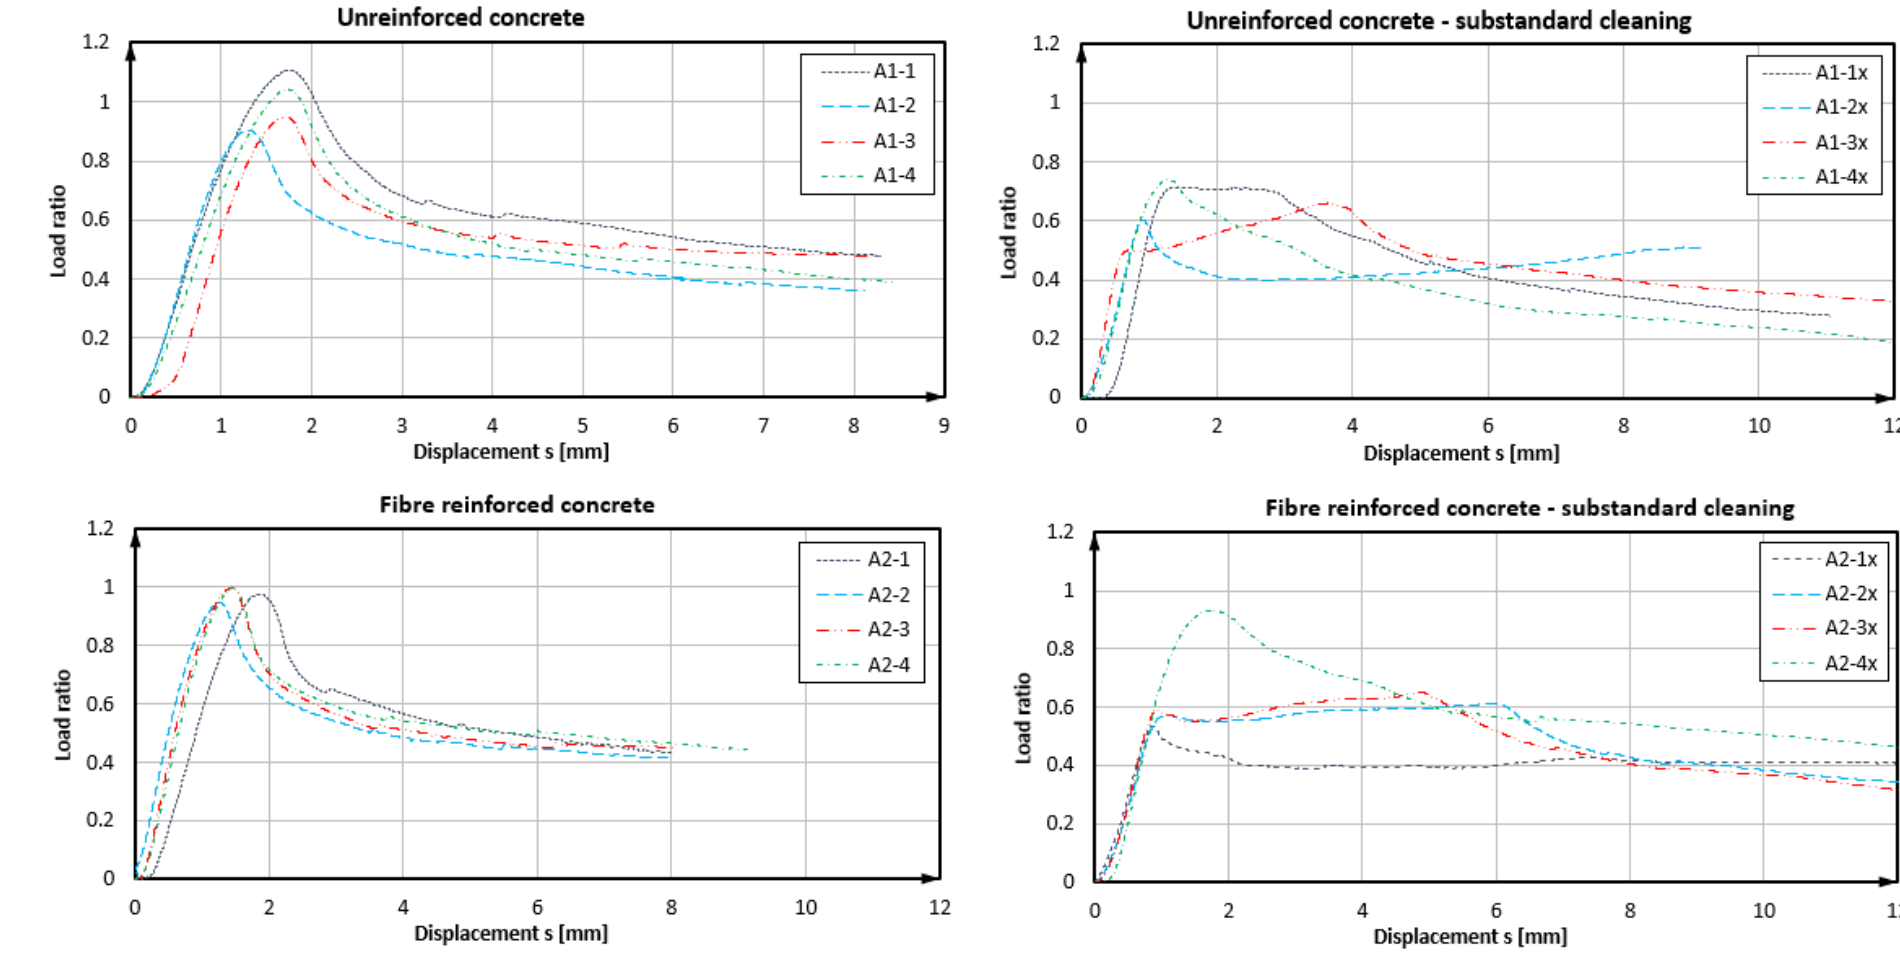
Figure 6. Load displacement curves of confined pull-out tests—Product A.